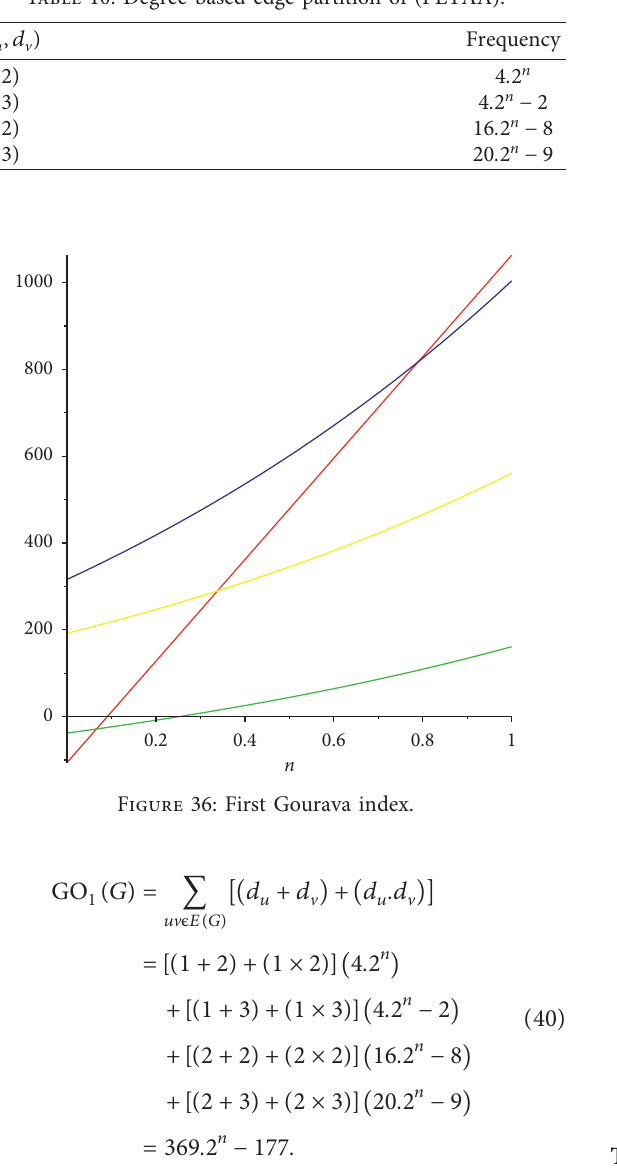
Figure 35: Poly(EThylene amide amine) dendrimer (PETAA). Table 10: Degree-based edge partition of (PETAA).